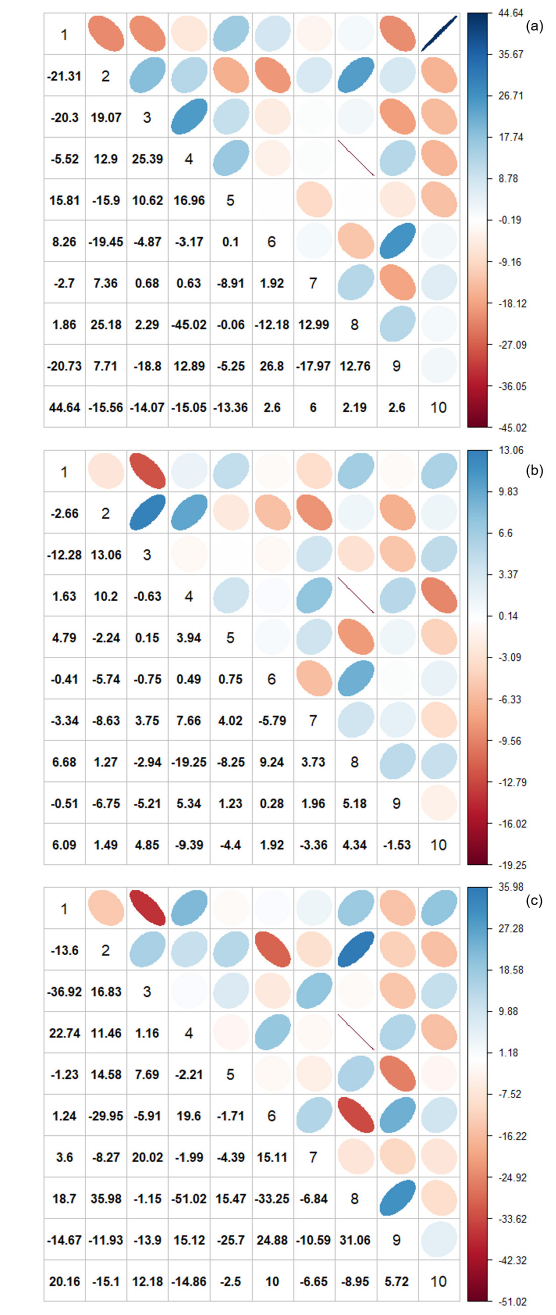
Figure 2. Specific combining ability for mega-trait 1 (plant stature) of 90 crosses conducted in Frederico Westphalen (a), Pato Branco (b) and Campos Novos